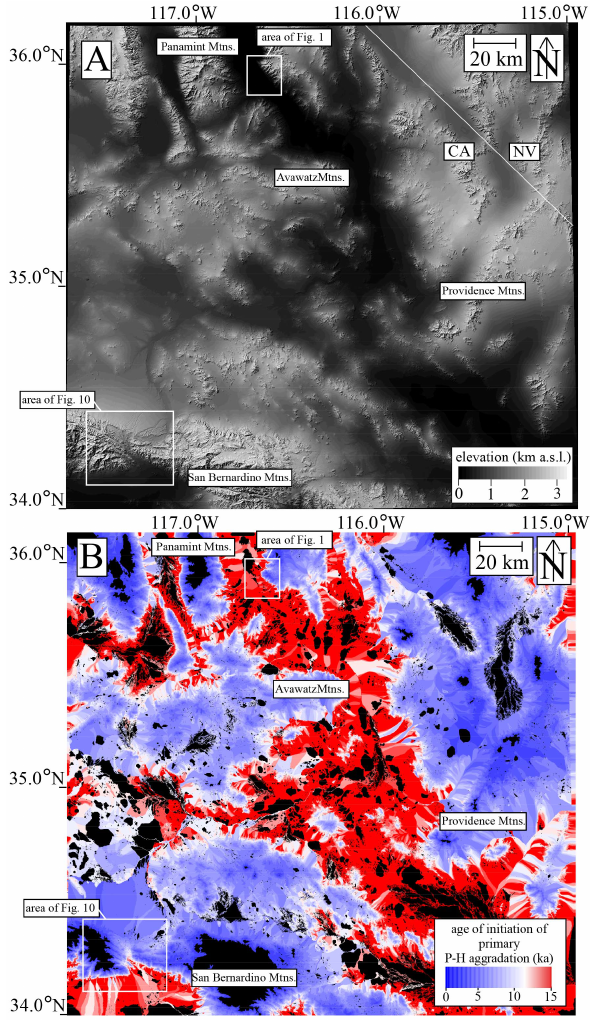
the model-predicted age of initiation of primary aggradation (i.e., unit Q3a of Bull, 1991) where deposits of such ages are present. Reddish areas indicate Pleistocene-aged Q3a deposits while bluish areas indicate Holocene-aged (0–11.7ka cal BP) Q3a deposits (if Q3a deposits are present). Black areas are locations not downstream (based on flow pathways defined by the modern DEM) from areas that have undergone P–H (Pleistocene–Holocene) changes in Ju- niperus